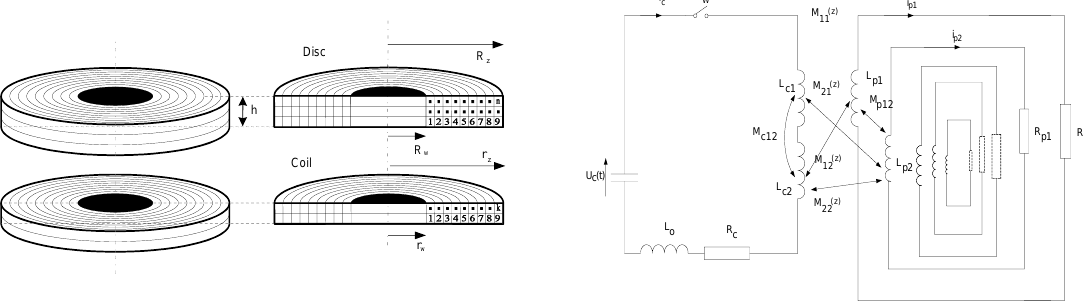
Figure 9. Discretization of the coil and disc and equivalent multi-loops circuit diagram of IDD.